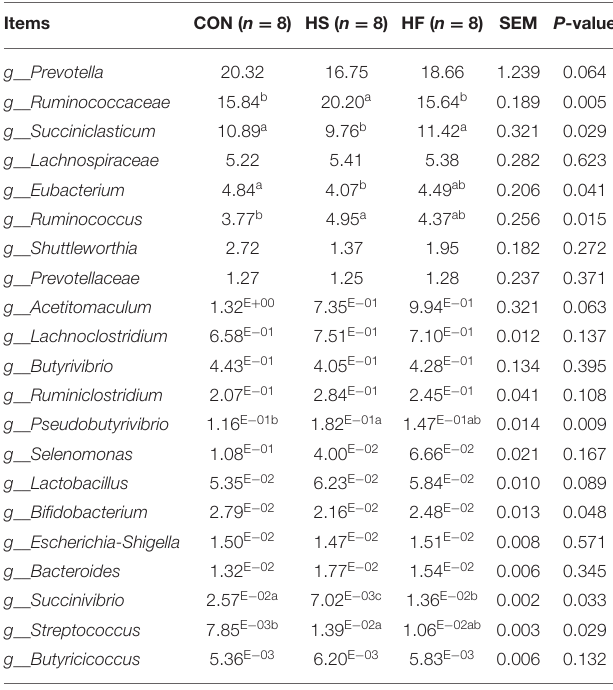
TABLE 7 | Effects of honeycomb flavonoids supplement on relative abundances of ruminal microbiota communities during heat stress conditions (level of genera, %).